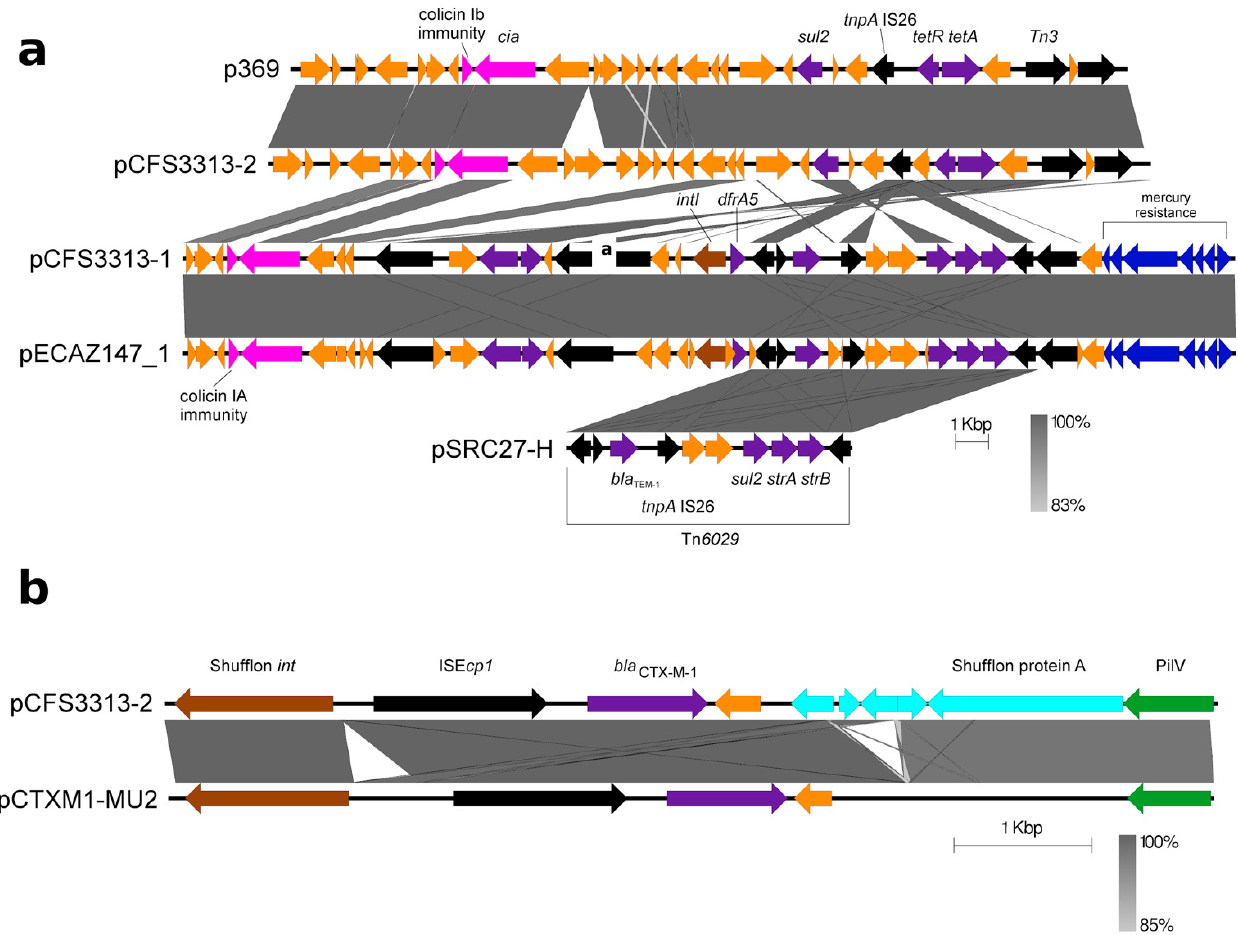
Figure 3. Complex AMR modules in pCFS3313-1 and pCFS3313-2. ( a ) Highlighted in the figure are three selected BLAST hits—plasmids p369, pECAZ147_1, and pSRC27-H. Plasmid p369 showed a higher degree of similarity with plasmid